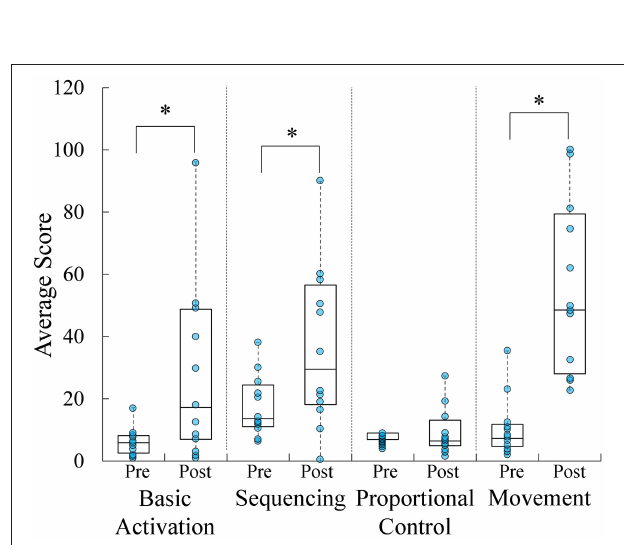
FIGURE 6 | Boxplots overlaid with raw data of average game score throughout the study. Participants significantly improved basic muscle activation, sequencing, and isolation during the course of the study. * p <